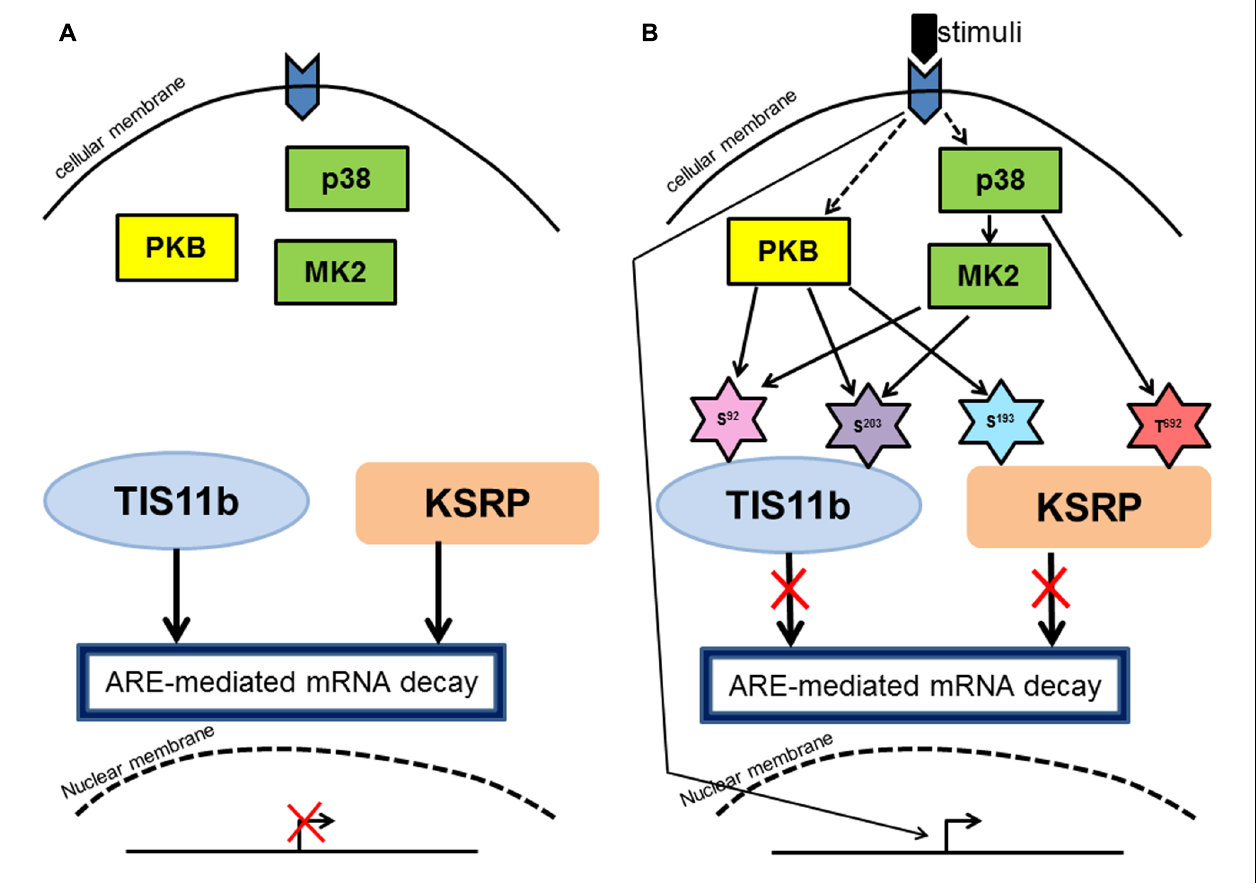
same phosphorylation sites, KSRP is phosphorylated at Ser 193 andThr 692 by PKB and p38 respectively.These phosphorylation events inhibit KSRP in mediating ARE-mediated mRNA decay.Transcription factors upon activation by signals from kinases drive transcription which is illustrated in the Figure 2 . The phosphorylation sites are shown in star shape